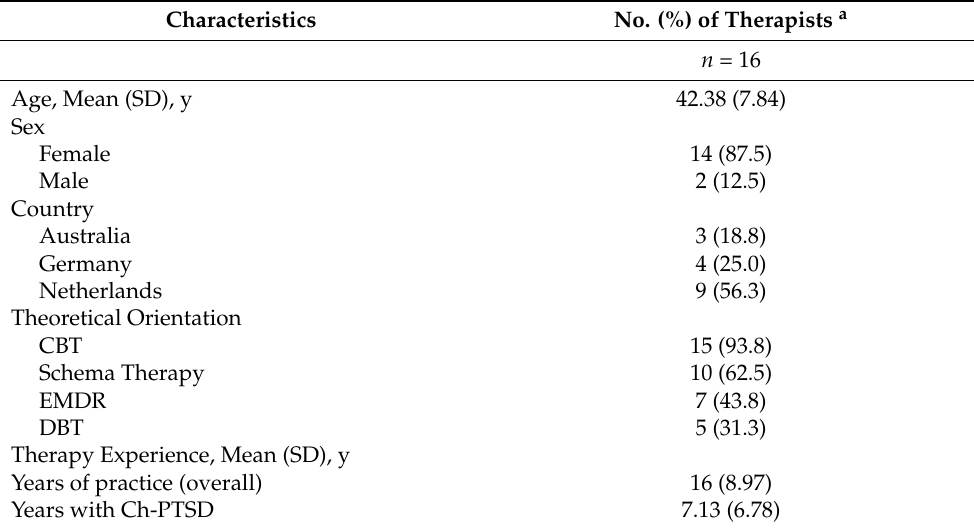
Table 2. Characteristics of IREM